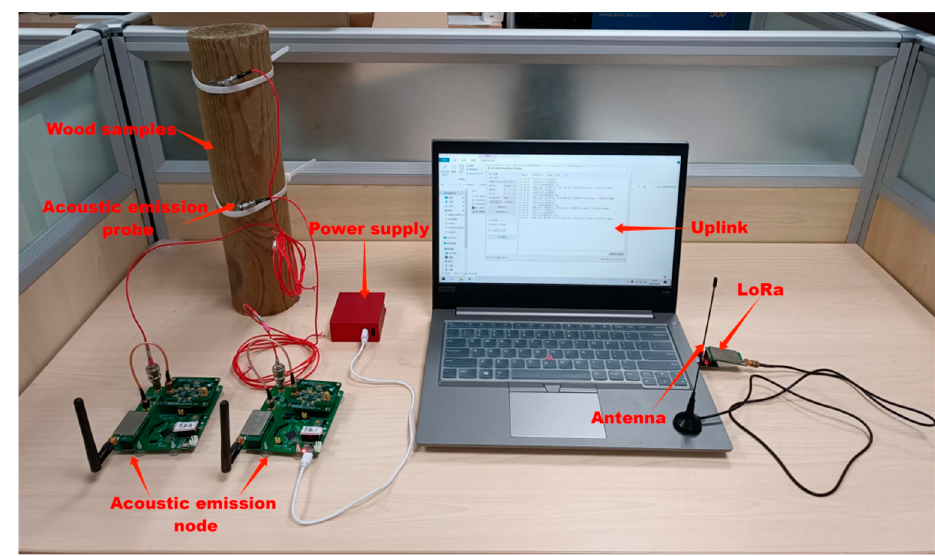
Figure 14. Physical view of sample data collection.